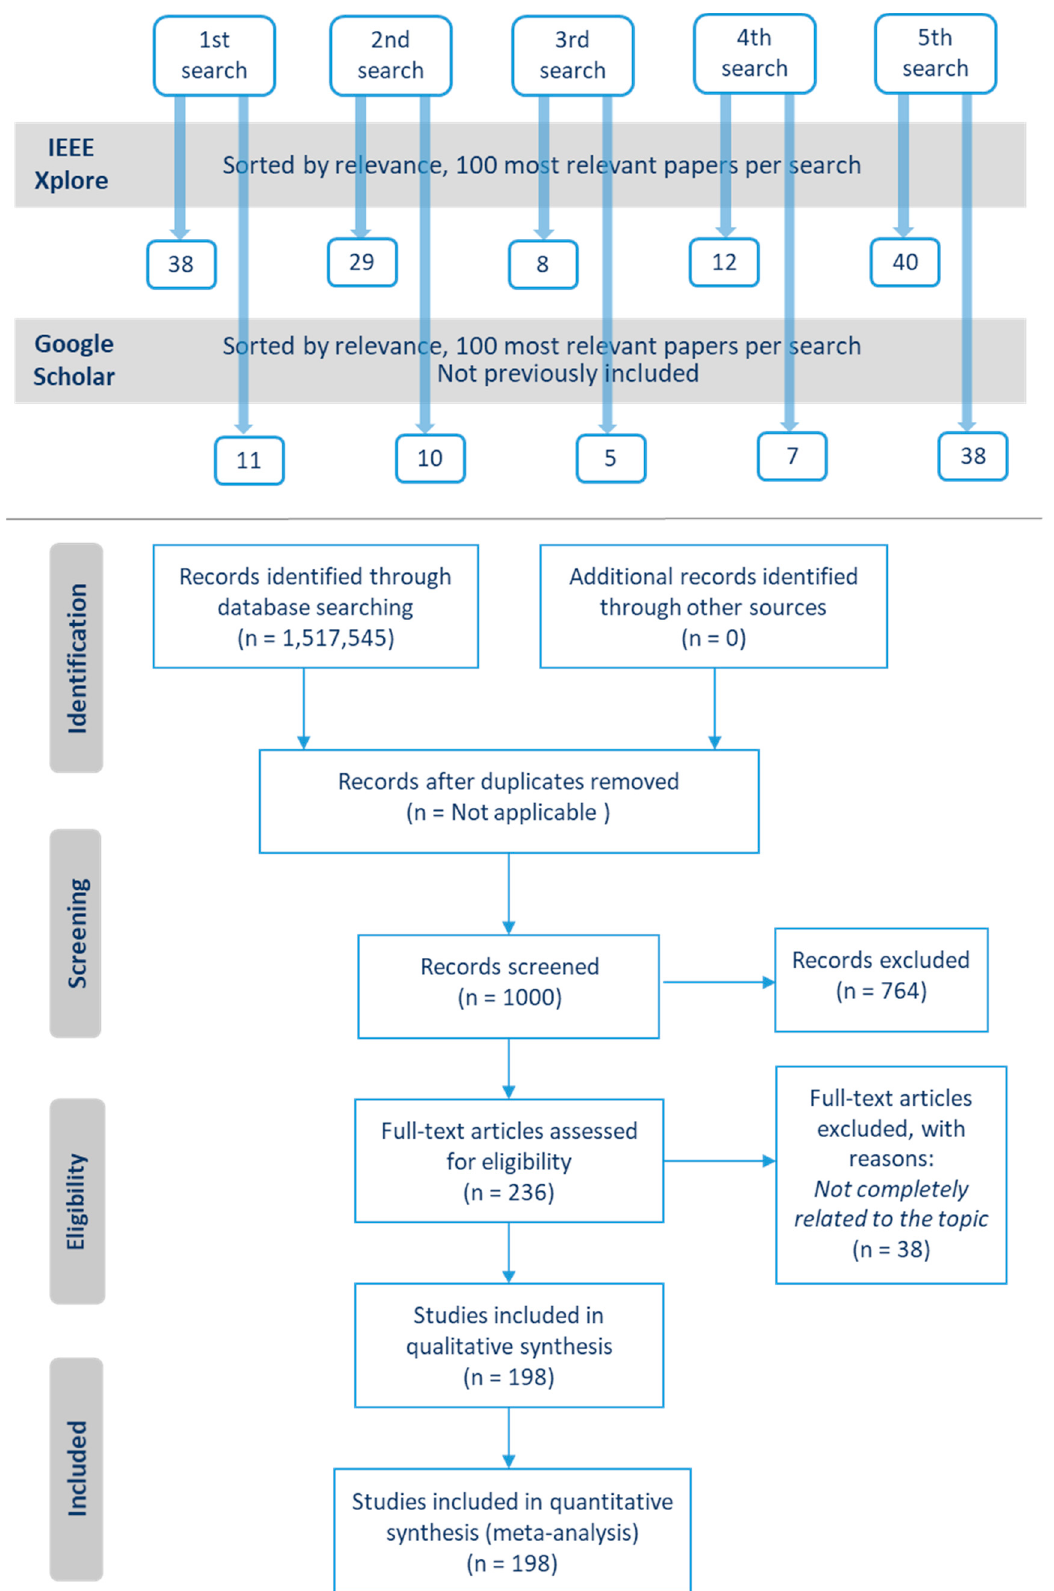
Figure 2. Literature search results and selection procedure ( top ). PRISMA diagram ( bottom ).